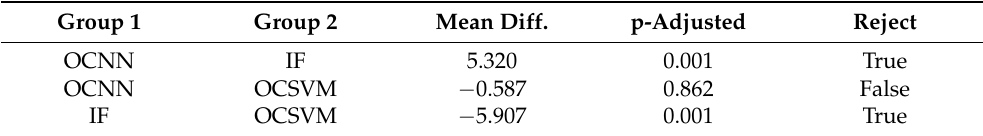
Table 8. Multiple comparison of mean F1-score for OCSVM, OCNN, and IF using Tukey’s range test at α =